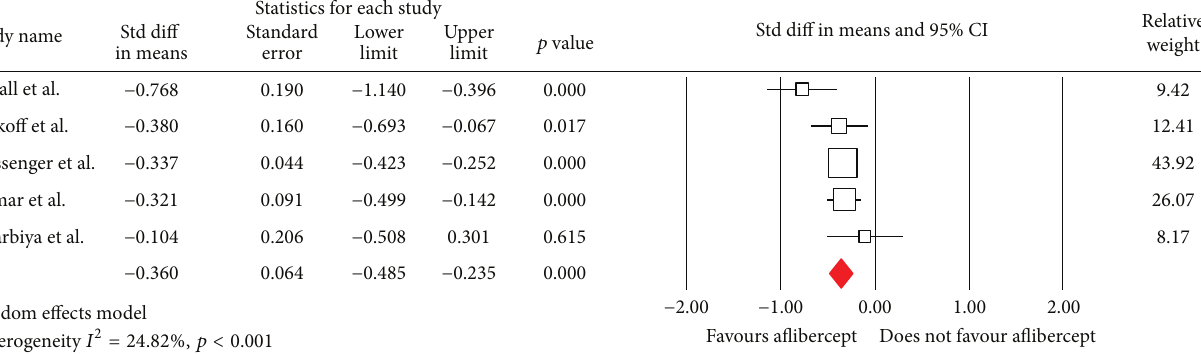
Figure 3: Forrest plot of five studies reporting comparative results of the central retinal thickness (CRT) six months after switching to aflibercept. The overall effect demonstrated a significant reduction in CRT. The lower and upper limit represents the 95% CI.